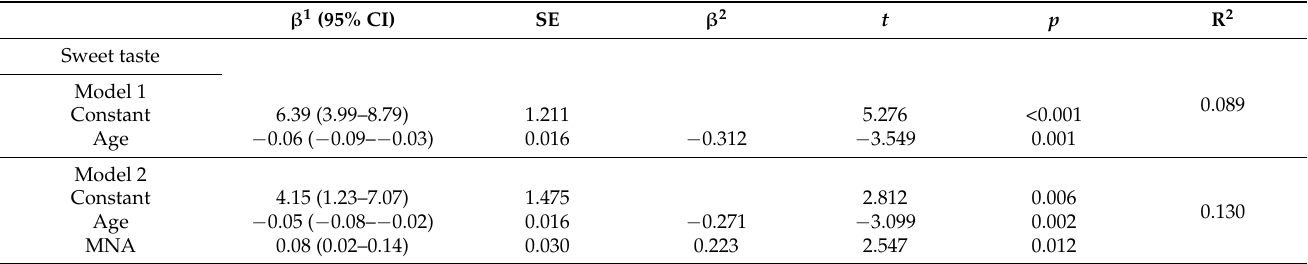
Table 3. Determinants of the Taste